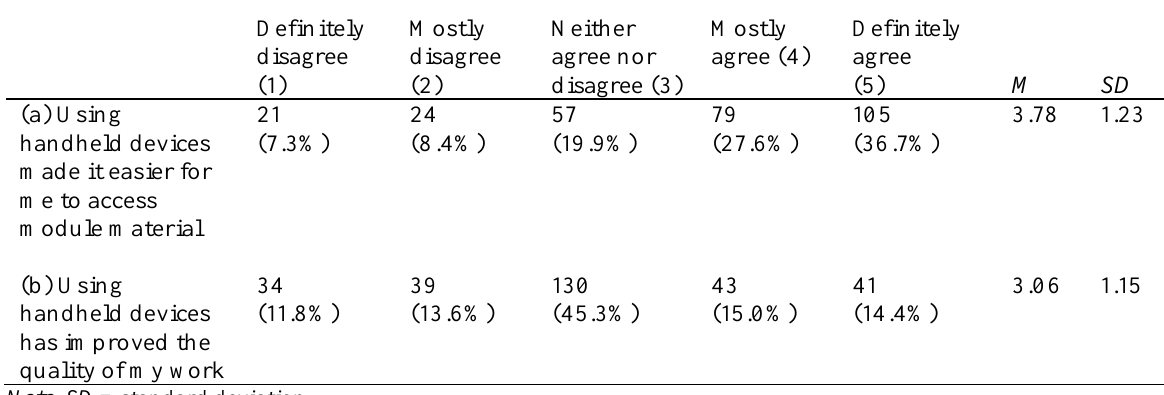
Student View About Impact of Handheld Device Use on Learning